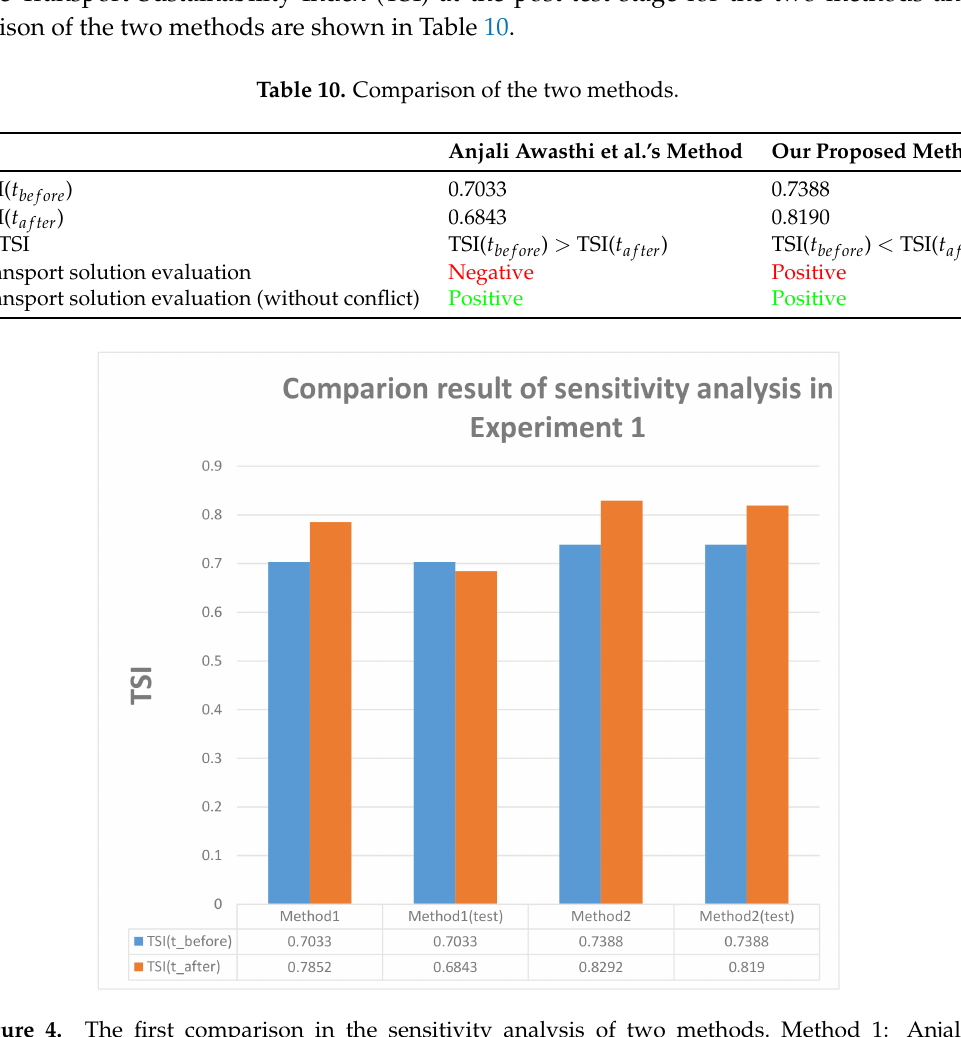
Figure 4. The first comparison in the sensitivity analysis of two methods. Method 1: Anjali Awasthi et al.’s method. Method 2: Our proposed